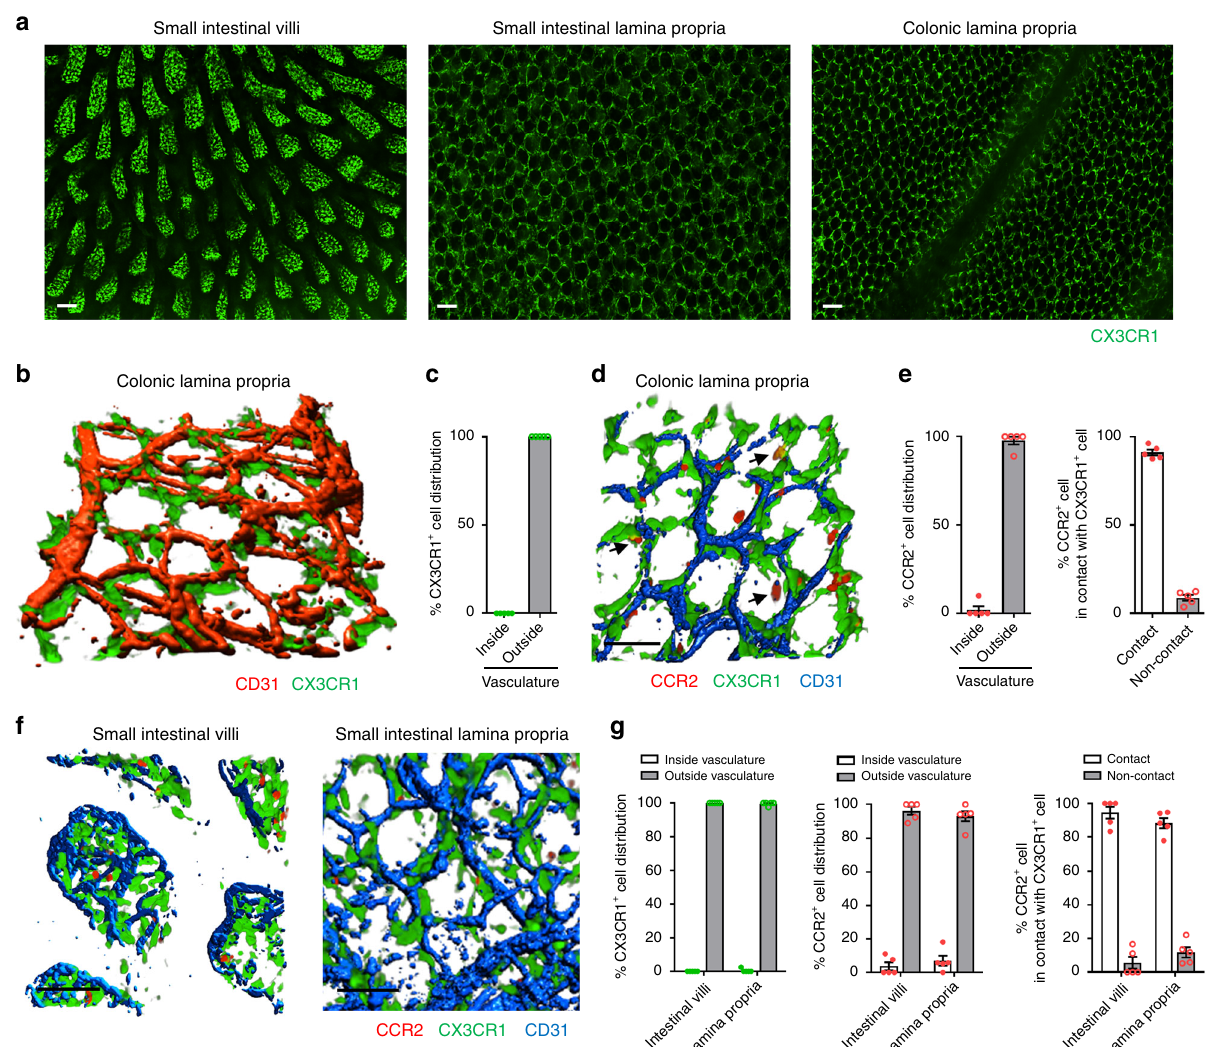
Fig. 1 Intestinal CX3CR1 + macrophages and CCR2 + monocytes constitute the close network that surrounds vasculature. a Representative stitched images (from 12 different fi elds of view) of small intestinal villi (left), small intestinal lamina propria (LP) (middle), and colonic LP (right) in Cx3cr1 GFP/ + mice. Scale bars, 100 μ m. b Representative three-dimensional (3D) image of CX3CR1 + macrophages (green) in colonic LP and c quanti fi cation of their distribution. n = 5. d Representative 3D image of colonic LP CX3CR1 + macrophages and CCR2 + cells (red) at basal condition in Cx3cr1 GFP/ + Ccr2 RFP/ + mouse. Arrows indicate orange/yellow cells. Scale bar, 50 μ m. ( e ) Localization of colonic LP CCR2 + cells and their positional relationships with CX3CR1 + cells. n = 5. (f) Representative 3D images of small intestinal villi (left) and LP (right). Scale bars, 50 μ m. g Localization of small intestinal CX3CR1 + and CCR2 + cells in villi and LP and their positional relationships. n = 5. Data represent mean ± SEM. Source data are provided as a Source Data fi